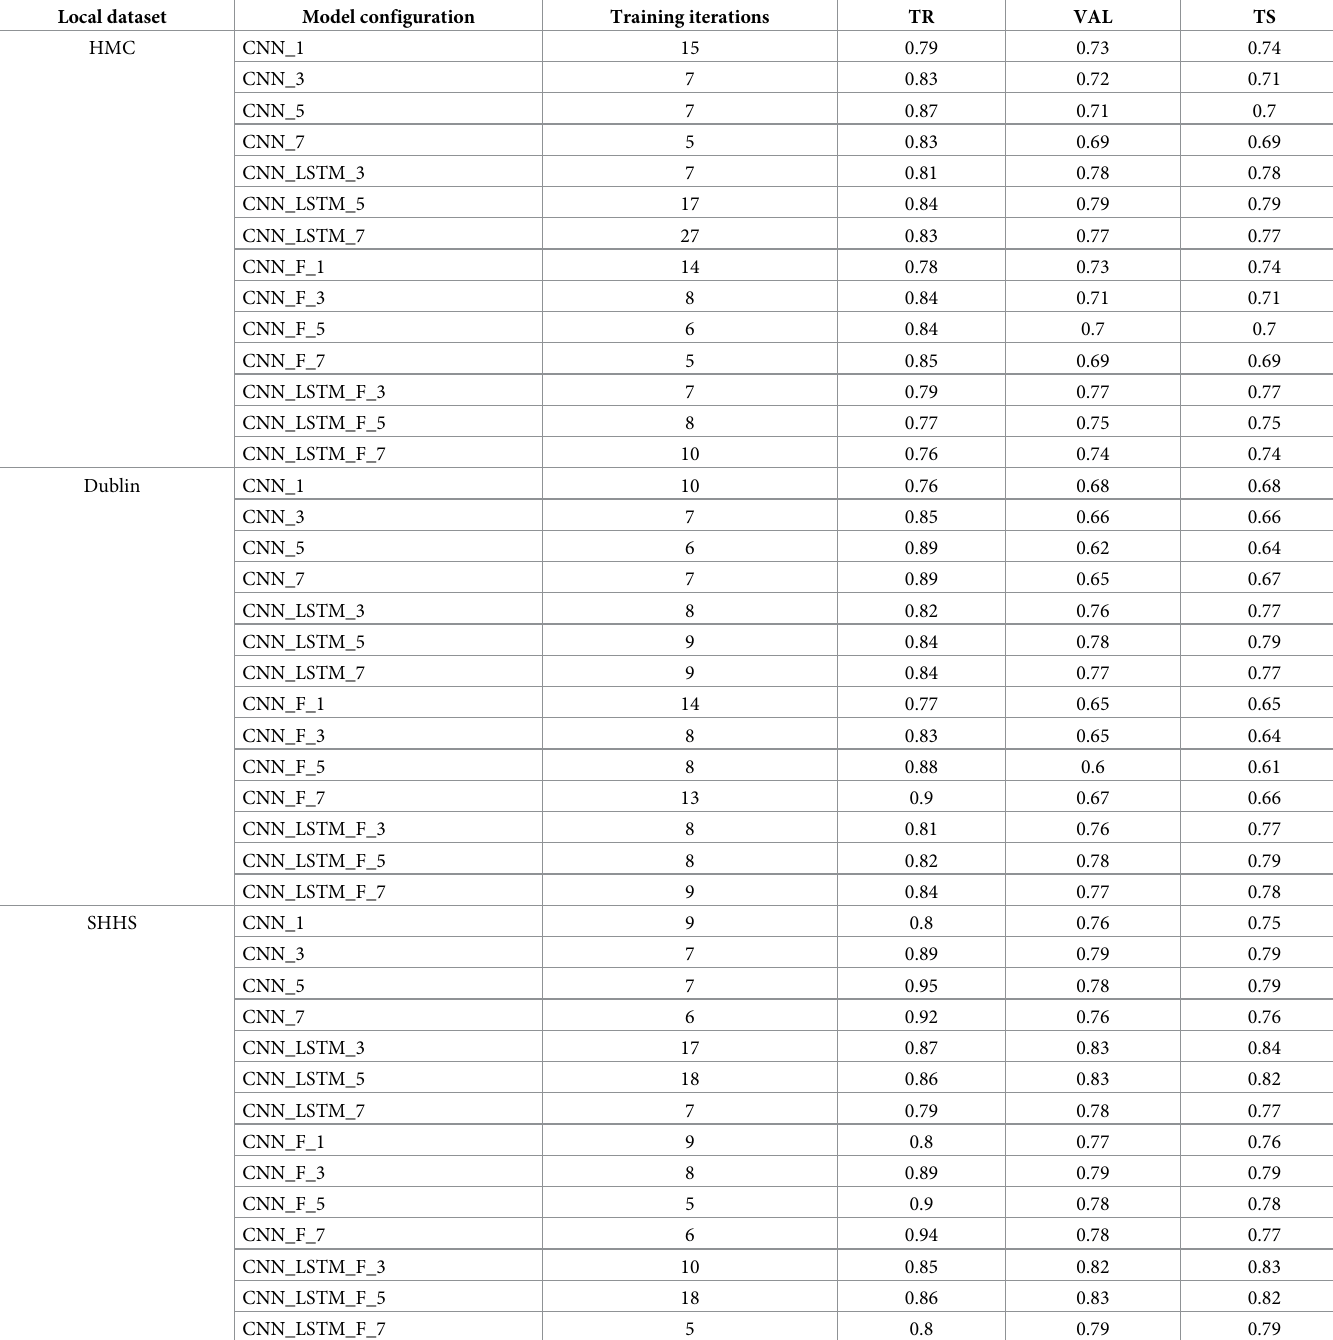
Table 1. Performance results of each individual model on the local validation scenario. Local